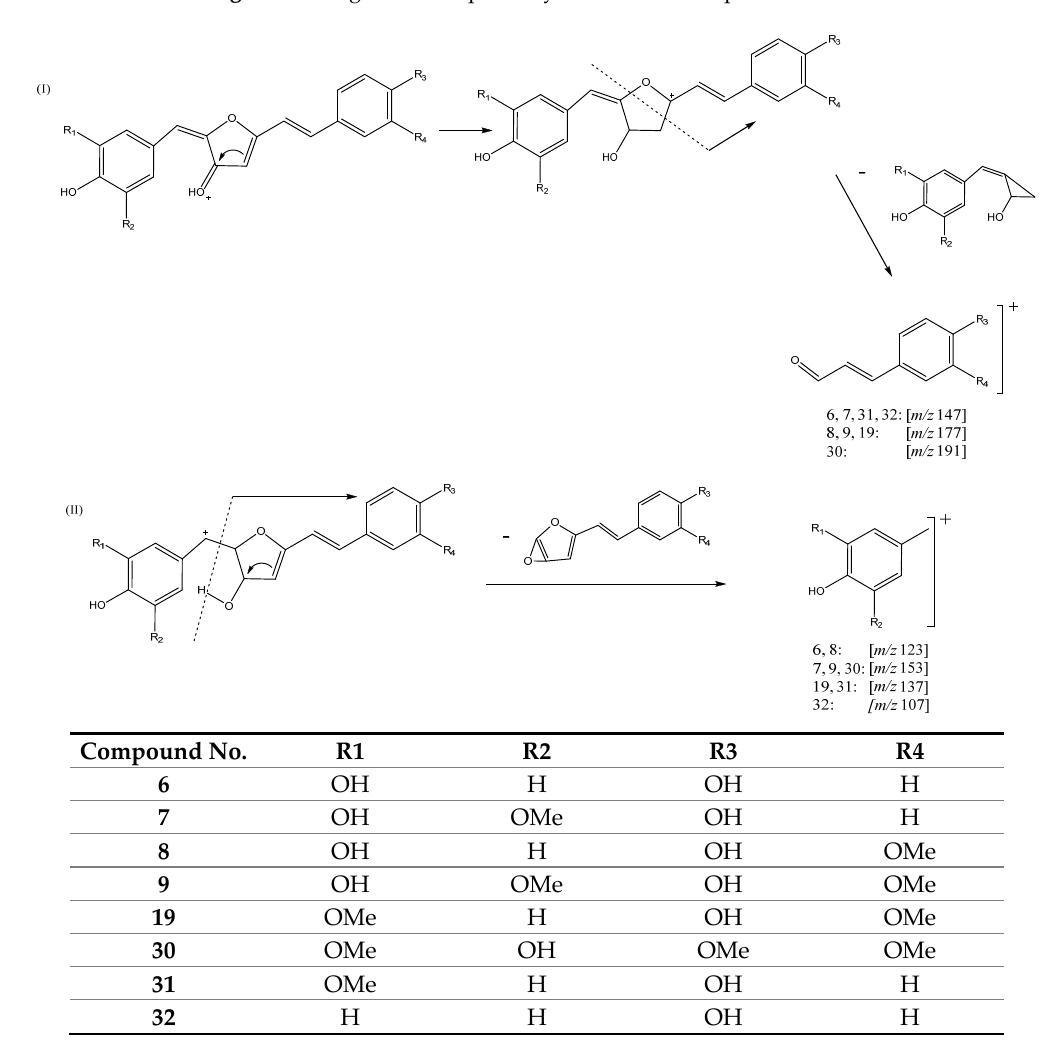
Figure 12. Fragmentation pathways I and II for compounds 6 , 7 , 8 , 9 , 19 , 30 , 31 and 32 .